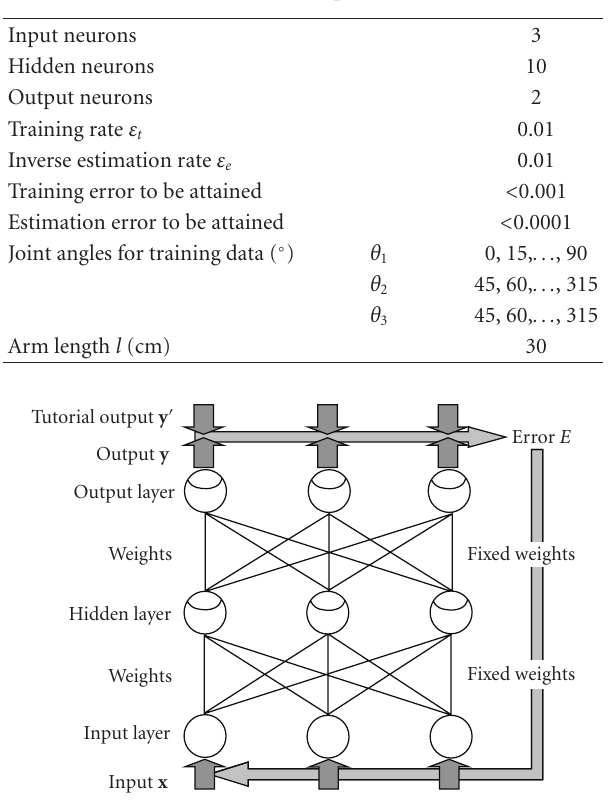
Table 1: Network parameters.